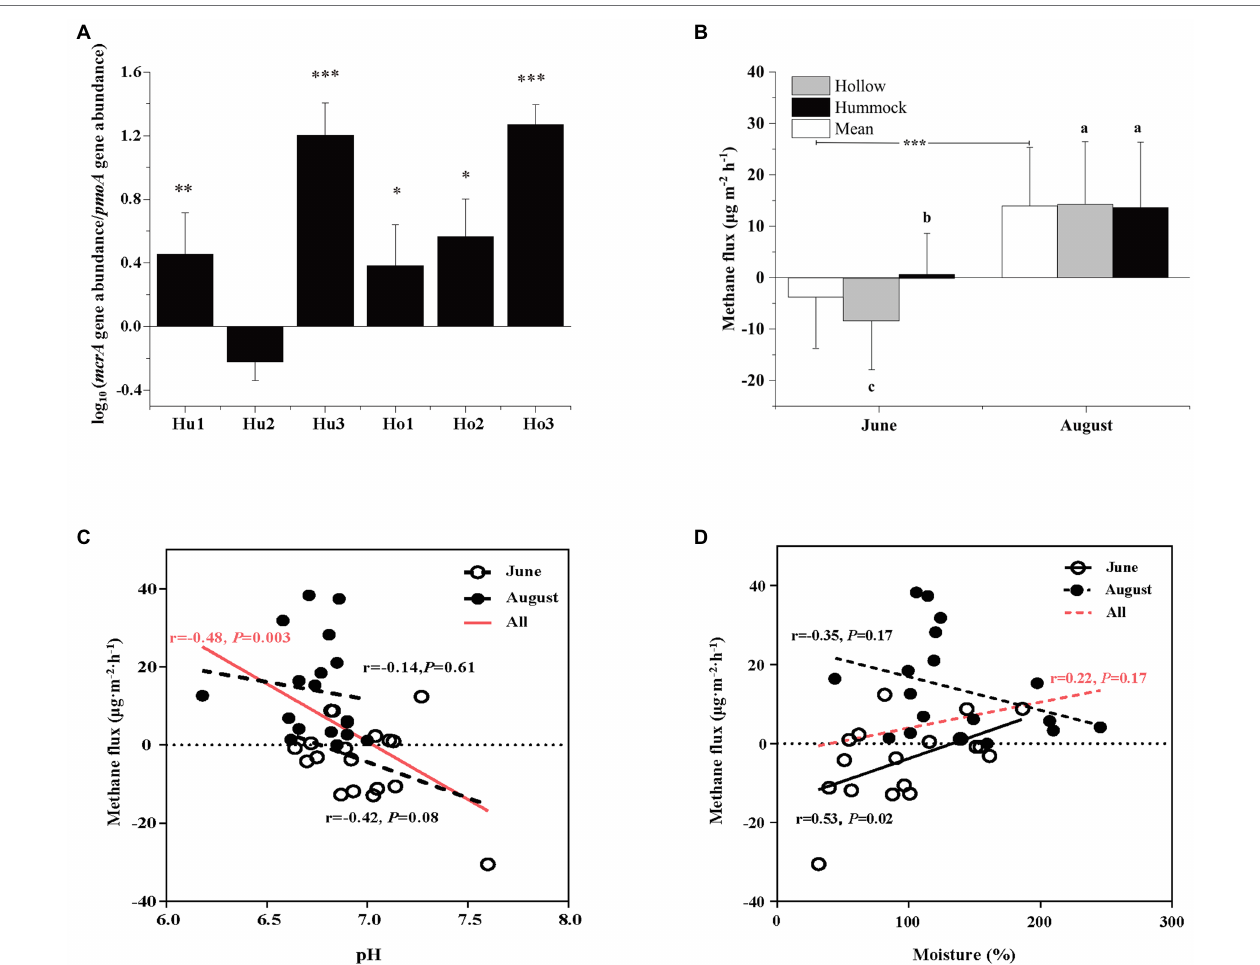
FIGURE 2 | (A) Comparison of Log-transformed mcrA -to- pmoA gene copy numbers. Asterisks indicate the significant higher abundance of mcrA gene copy numbers (i.e., ratio > 1, *** p < 0.001, ** p < 0.01, and * p < 0.05). (B) The mean methane flux in June and August (white), and the methane flux in hollow (gray), and hummock soils (black) in June (pre-melting season) and August (melting season). Asterisks indicate significant differences between June and August measurements. Significant differences ( p < 0.05) by microtopography are indicated by different letters. (C) The relationships of methane flux in June (empty circle) and August (solid circle) with soil pH. (D) The relationships of methane fluxes in June (empty circle) and August (solid circle) with soil water content. The red lines in (C,D) indicate the relationship between methane fluxes (both June and August) with soil pH and soil water content. Error bars in (A,B) represent SD ( n = 3). The relationships are fitted by linear model and significant differences ( p < 0.05) were displayed by solid lines, whereas dotted lines indicate non-significant relationships ( p >